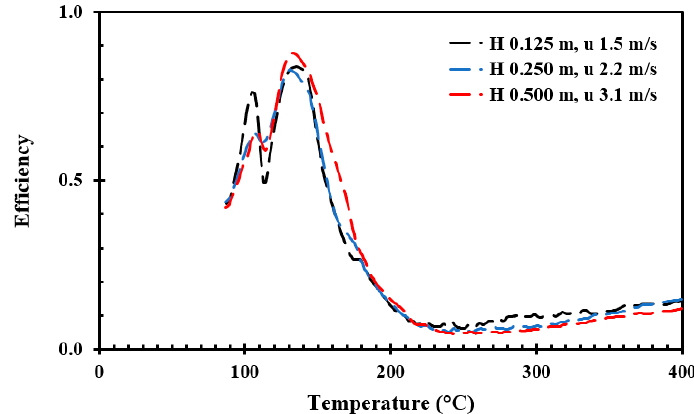
Figure 19. Cooling efficiency for 700 ppm acetone solution for droplet diameter 2.5 mm, horizontal orientation. Impingement heights and speeds are given in the figure label.